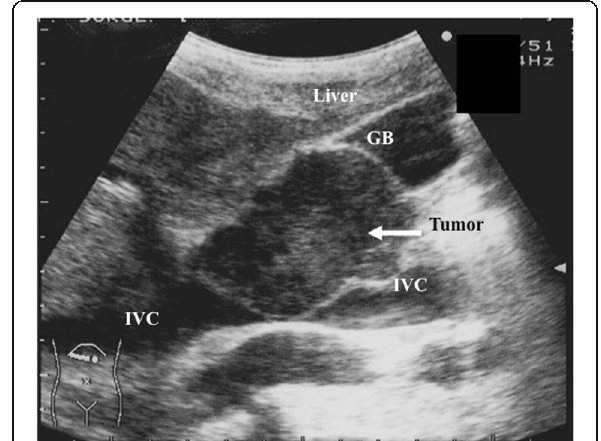
Fig. 1 Abdominal computed tomography. Contrast-enhanced abdominal computed tomography demonstrated a large heterogeneous mass, 5 cm in length that was compressing the IVC and head of